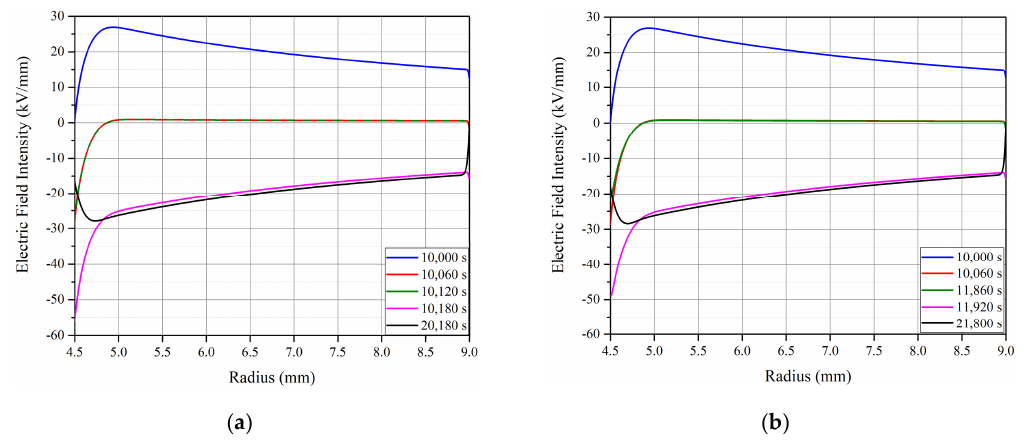
Figure 15. Time-varying electric field distribution after polarity reversal at 250 A: ( a ) Potential zero duration 60 s; ( b ) 1800 s.